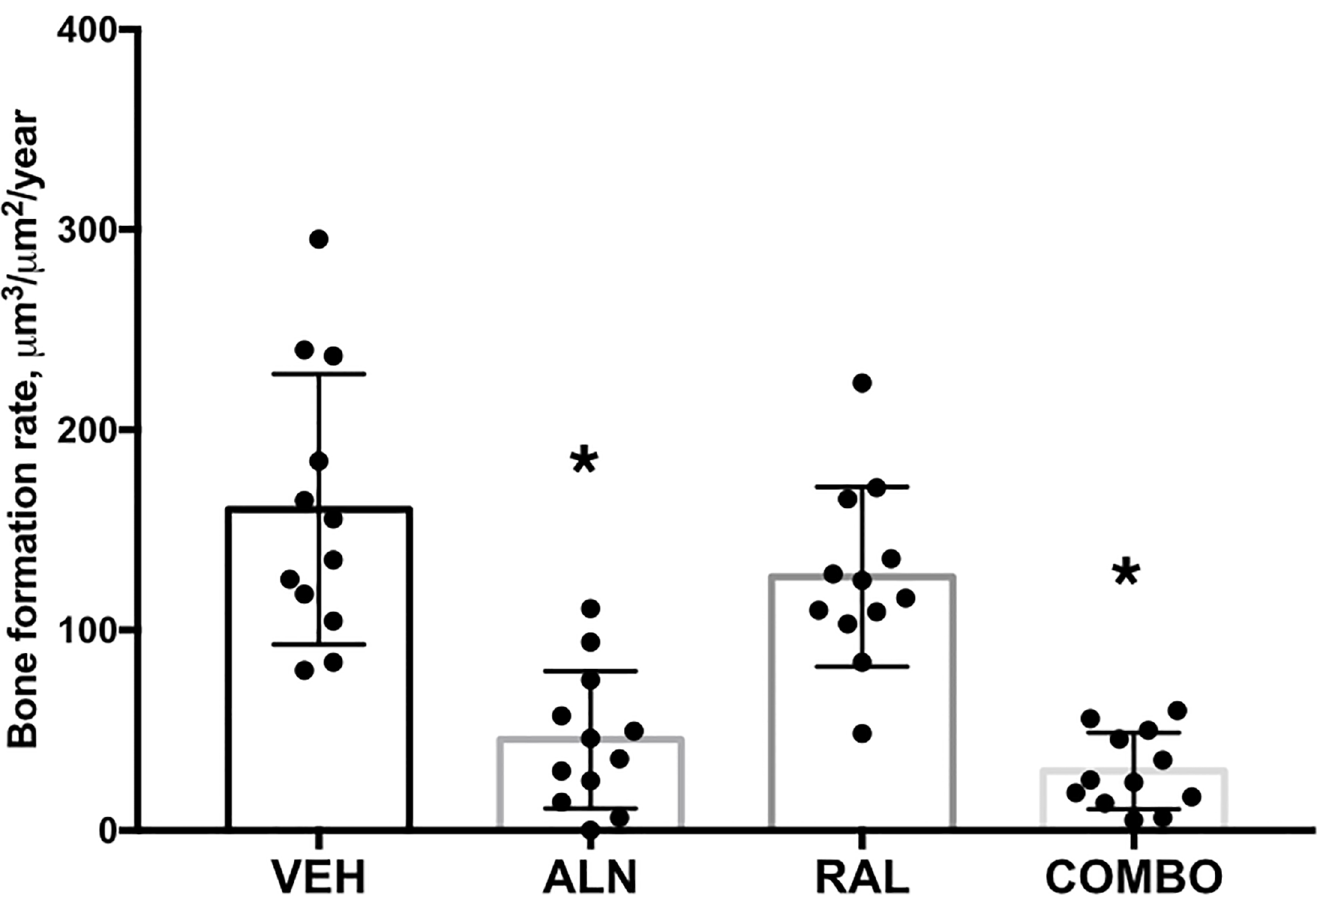
Fig 1. Iliac crest trabecularbone formation rate. * p < 0.05 versus